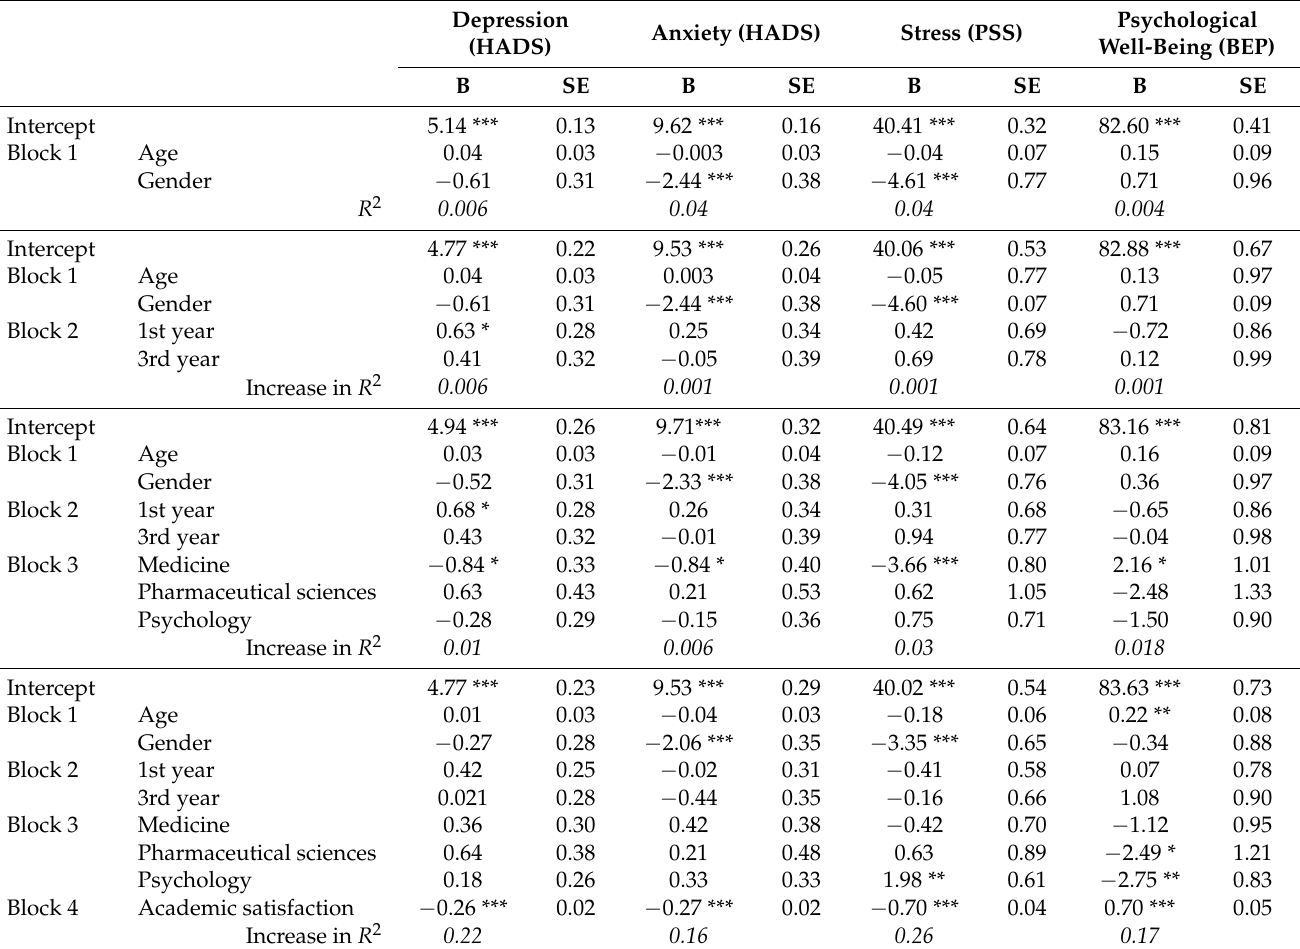
Table 2. Hierarchical regression of session 1